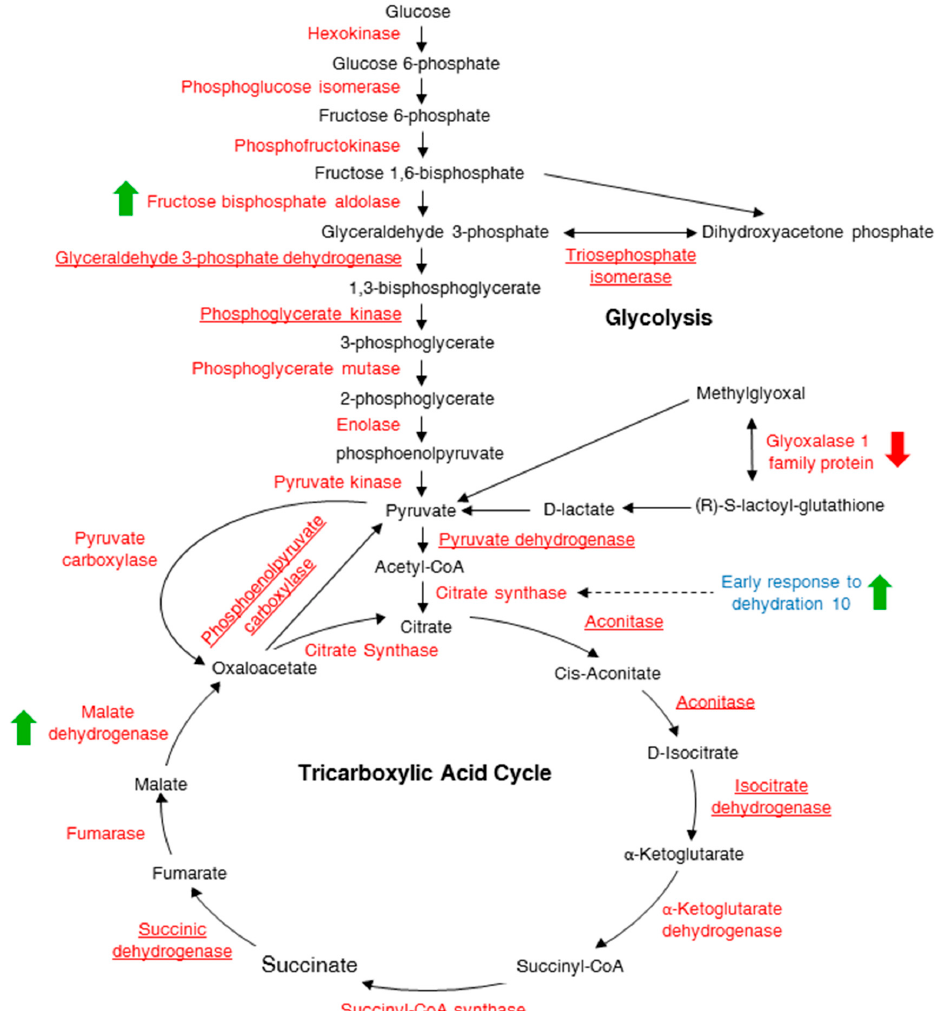
Figure 2. A schematic diagram of the glycolysis and tricarboxylic acid (TCA) cycle pathways showing proteins differentially expressed post cAMP treatment. The glycolysis and TCA metabolic products are shown in black, the enzymes are in red and a protein associated with the TCA cycle is shown in blue. The green arrows indicate proteins that accumulate in response to cAMP while the red arrow indicates a protein that is reduced in quantity. All the other proteins underlined are some of the proteins identified in the current study that are not changing in abundance after cAMP treatment.